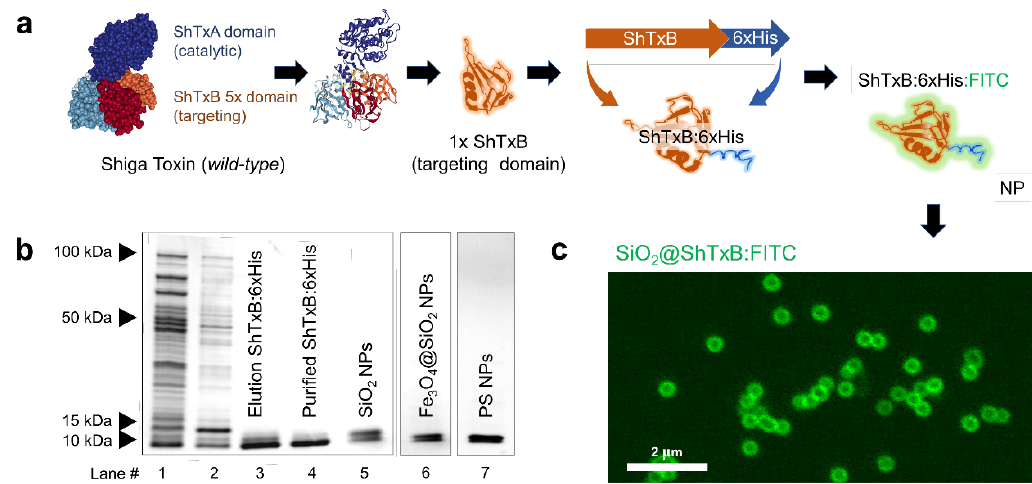
Figure 2. Ligand protein design. ( a ) Different domains in the structure of the Shiga toxin (ShTx). A single B domain (ShTxB) colored in orange is shown (UniProtKB ref. P09386). A diagram of the genetically modified ShTxB chimera protein and its situation on the nanoparticle is shown. The electrostatic interaction of the 6xHis tail orients the ligand peripherally on the particle. ( b ) SDS-PAGE analysis of ShTxB protein at different production and purification steps. (Lane# 1) protein expression in bacteria, (#2) column wash, (#3) elution of the protein from the column with imidazole, and (#4) PD-10 purified ShTxB used for bioconjugation. Lanes #5-6 show ShTxB stripped from functionalized SiO2, Fe 3 O 4 @SiO 2 , and PS particles (#7). ( c ) Confocal microscopy single Z plane image of 500 nm SiO 2 particles bioconjugated with ShTxB coupled to FITC. The fluorescent halo around the particle is the FITC-stained recombinant protein.